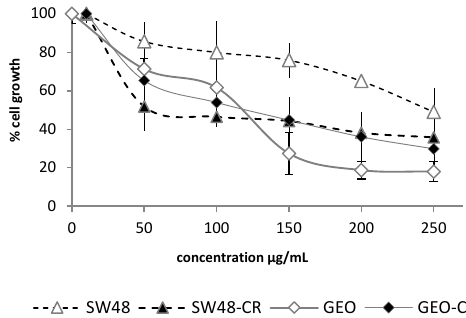
Figure 2. Antiproliferative activity evaluation of O. diffusa against the SW48, SW48-CR, GEO, and GEO-CR cell lines. Cell growth is expressed as percentage from control, and it is plotted on the vertical axis, while doses of plant extracts are reported on the horizontal axis.